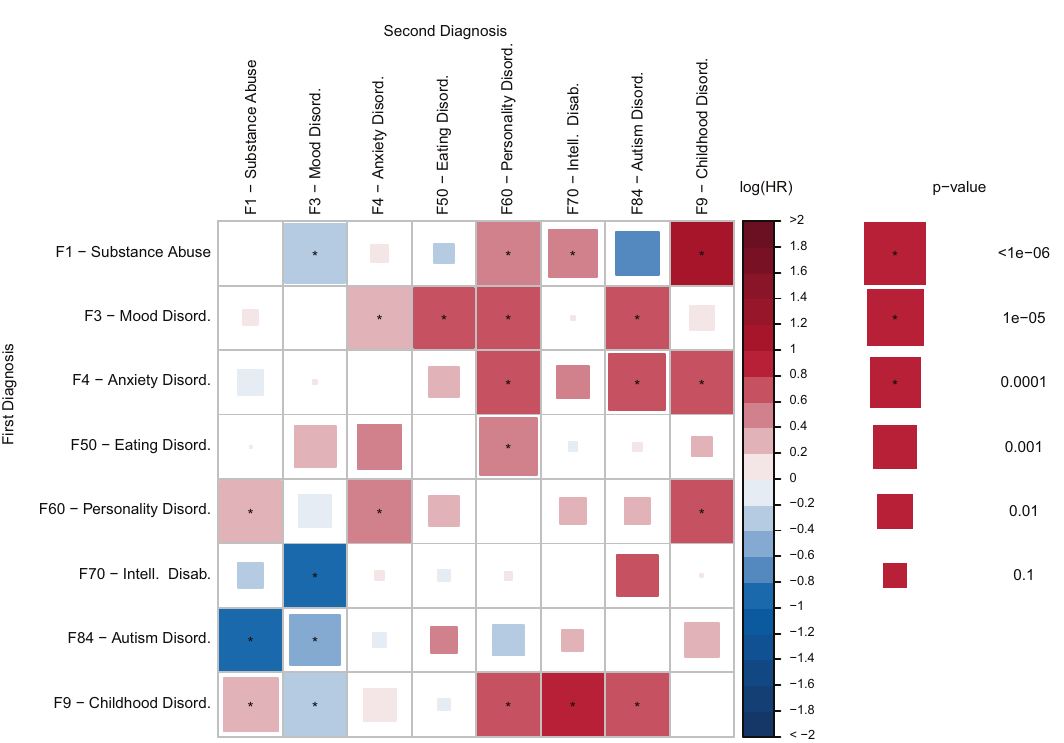
Fig. 2 Hazard ratio of eight comorbid psychiatric disorder categories conditioned on a prior diagnosis of each of the seven other psychiatric disorder categories estimated in 5432 individuals with schizophrenia. The fi gure displays the results of a Cox Proportional Hazard model. For each of the eight categories of psychiatric disorders (2nd diagnosis), the color indicates how the hazard depends on a previous diagnosis of each the seven other categories (1st diagnosis). All models are adjusted for age and sex. Square size indicates the uncorrected P -value of a two-sided Wald test with one degree of freedom. * indicates signi fi cance after a Bonferroni correction for 56 tests. P -values are unadjusted. The N (2 × 2 table) for each Cox regression is provided in Supplementary Table S2 along with the exact P -values.